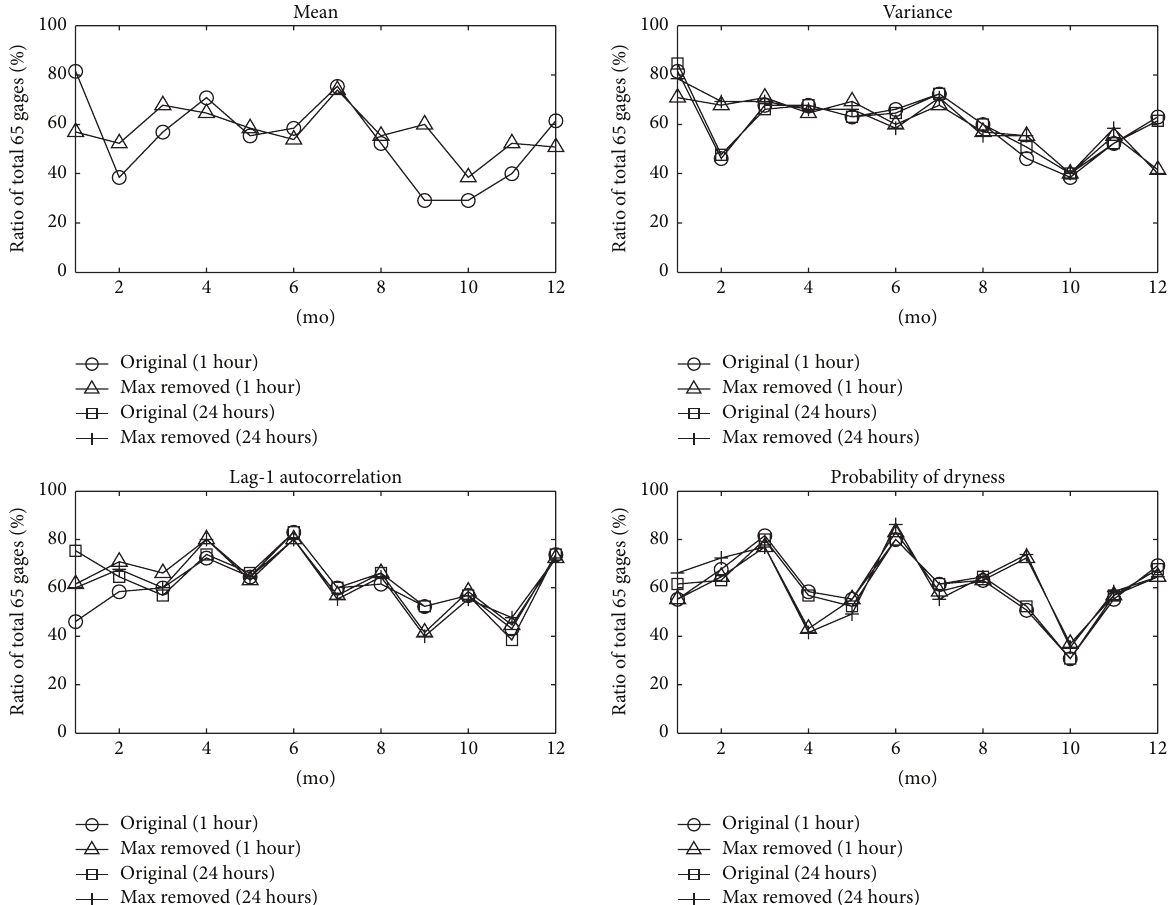
Figure 15: Comparison of the Mann-Kendall test rejection rates among 65 gages before and after removing the greatest yearly precipitation